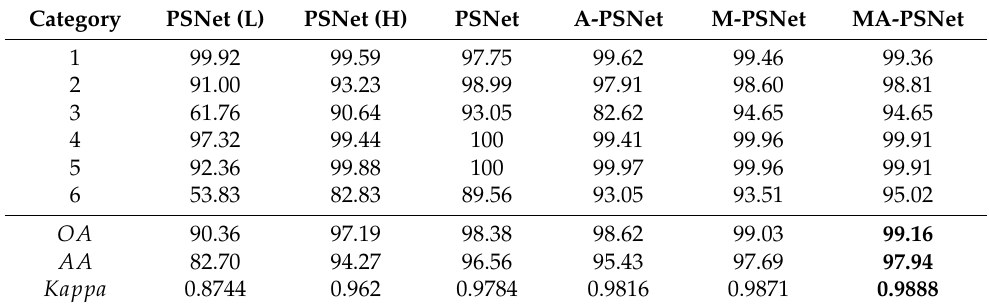
The bold refers to the best OA , AA , and Kappa performance. Table 4. Trento: Classification accuracies for per class, OA , AA (in %), Kappa coefficient (is of no unit). Category PSNet